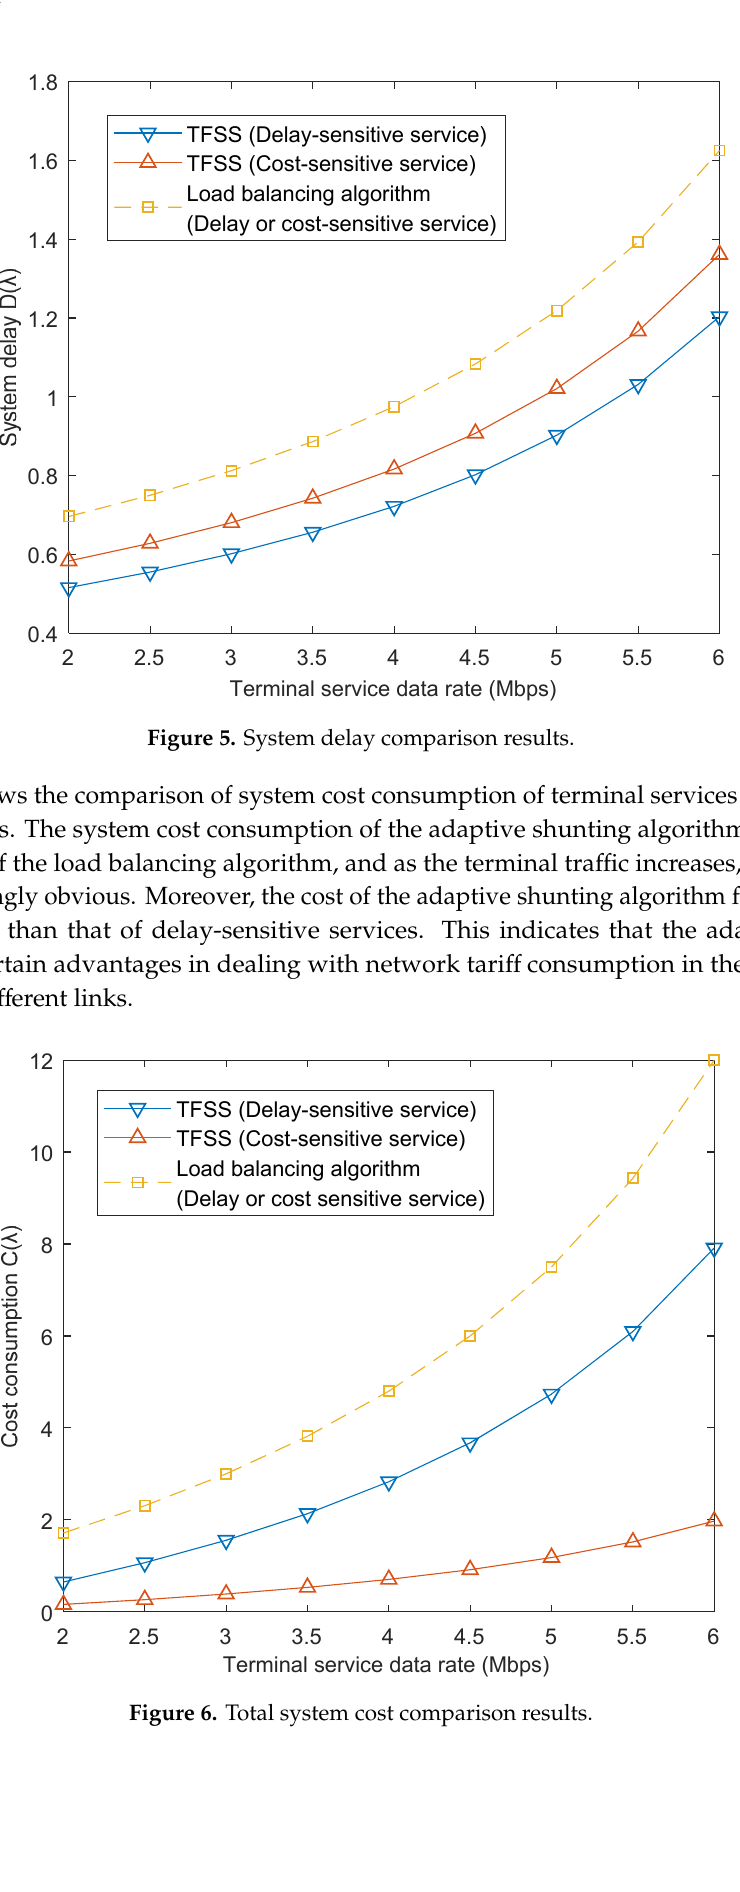
Figure 6. Total system cost comparison results.